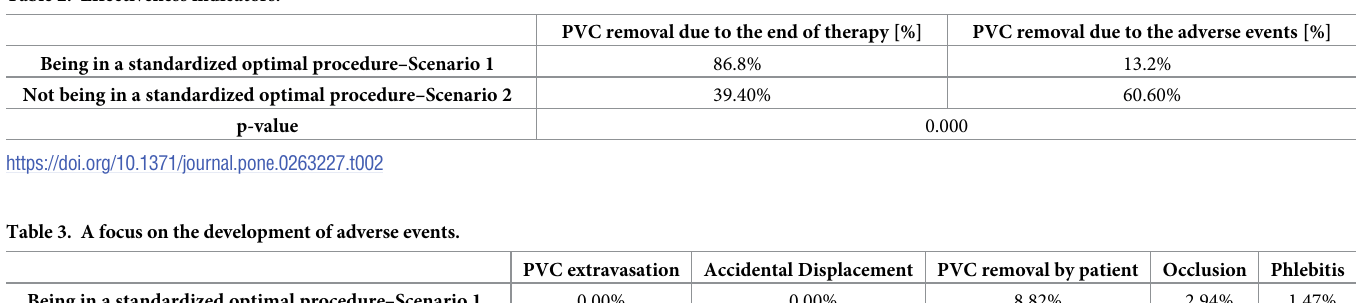
Table 2. Effectiveness indicators.